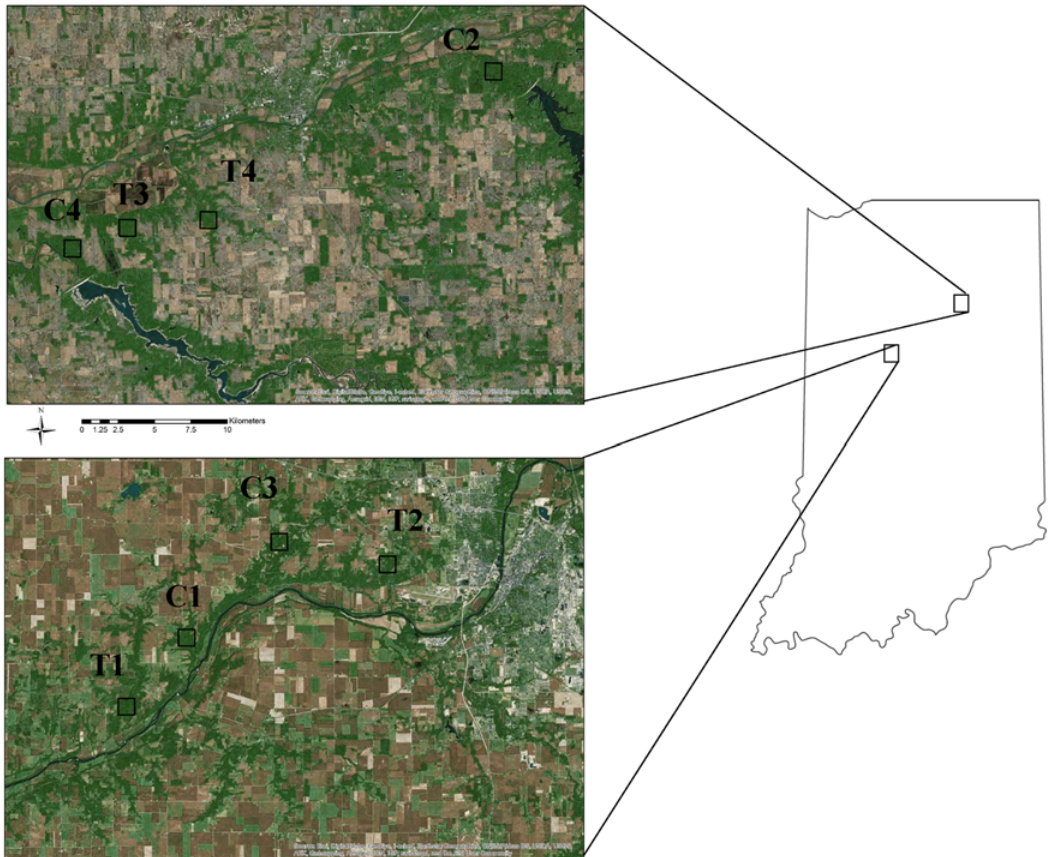
Figure 1. Map of study area showing the distribution of control ‘ C ’ and treatment ‘ T ’ sites throughout the Upper Wabash River Basin in Indiana, USA. Boxes represent actual bait distribution zones within each study